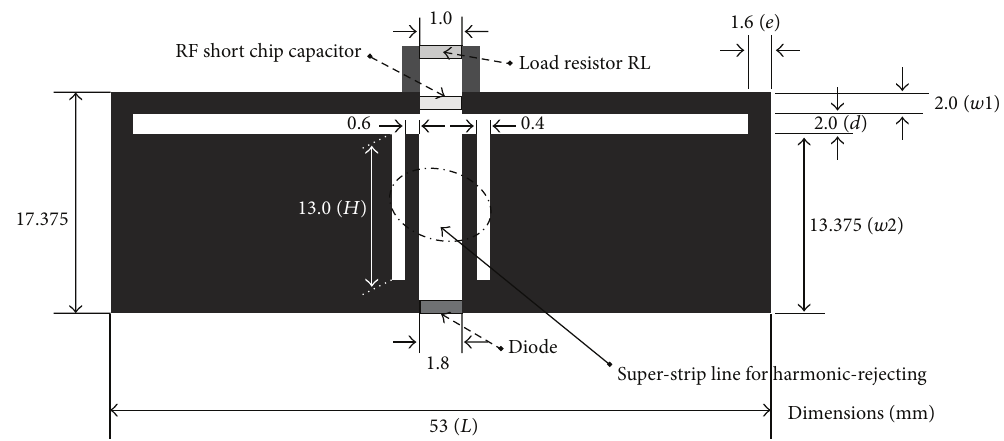
Figure 9: The geometry with detailed size of the proposed novel topology rectenna.